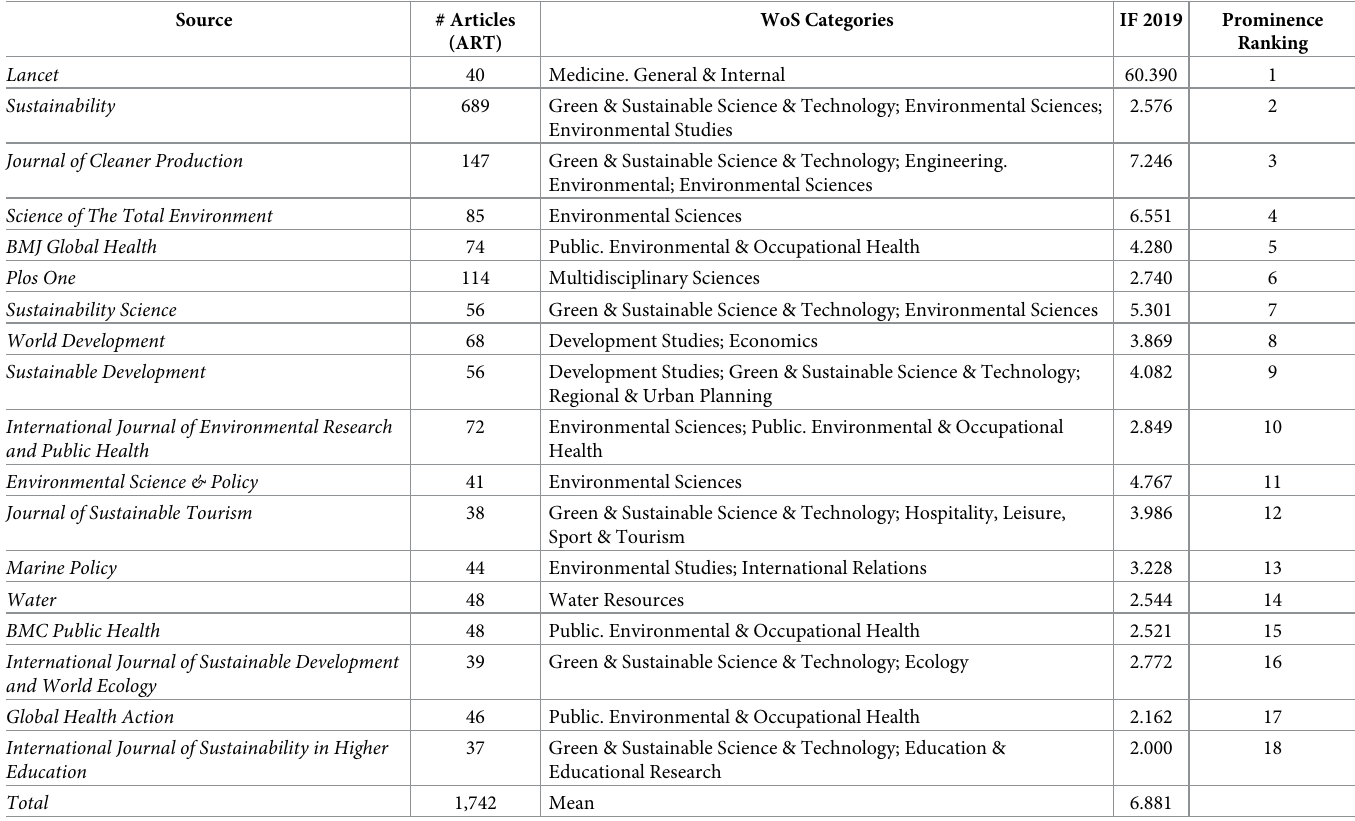
Table 4. Bradford nucleus